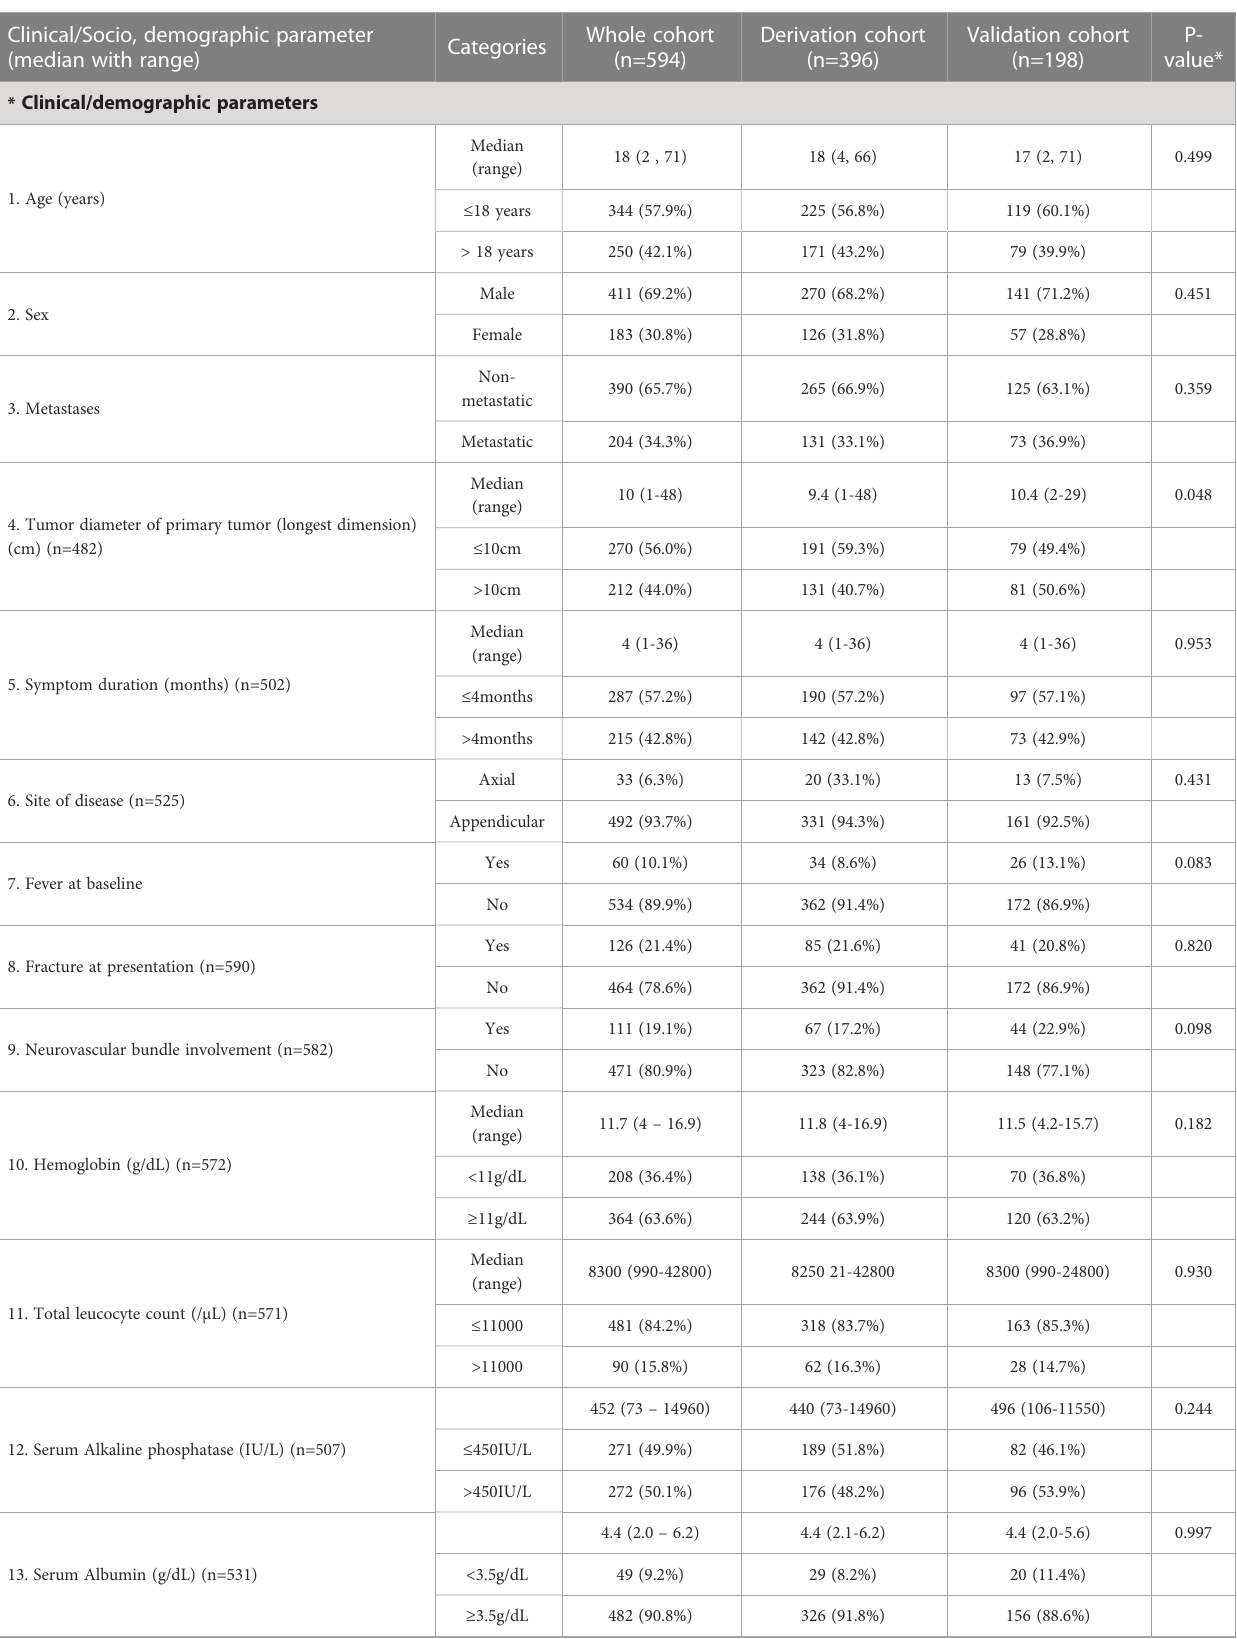
TABLE 1 Baseline clinical and socio, demographic characteristics in derivation (n=396), validation (n=198) and whole cohort (n=594). Clinical/Socio, demographic parameter (median with